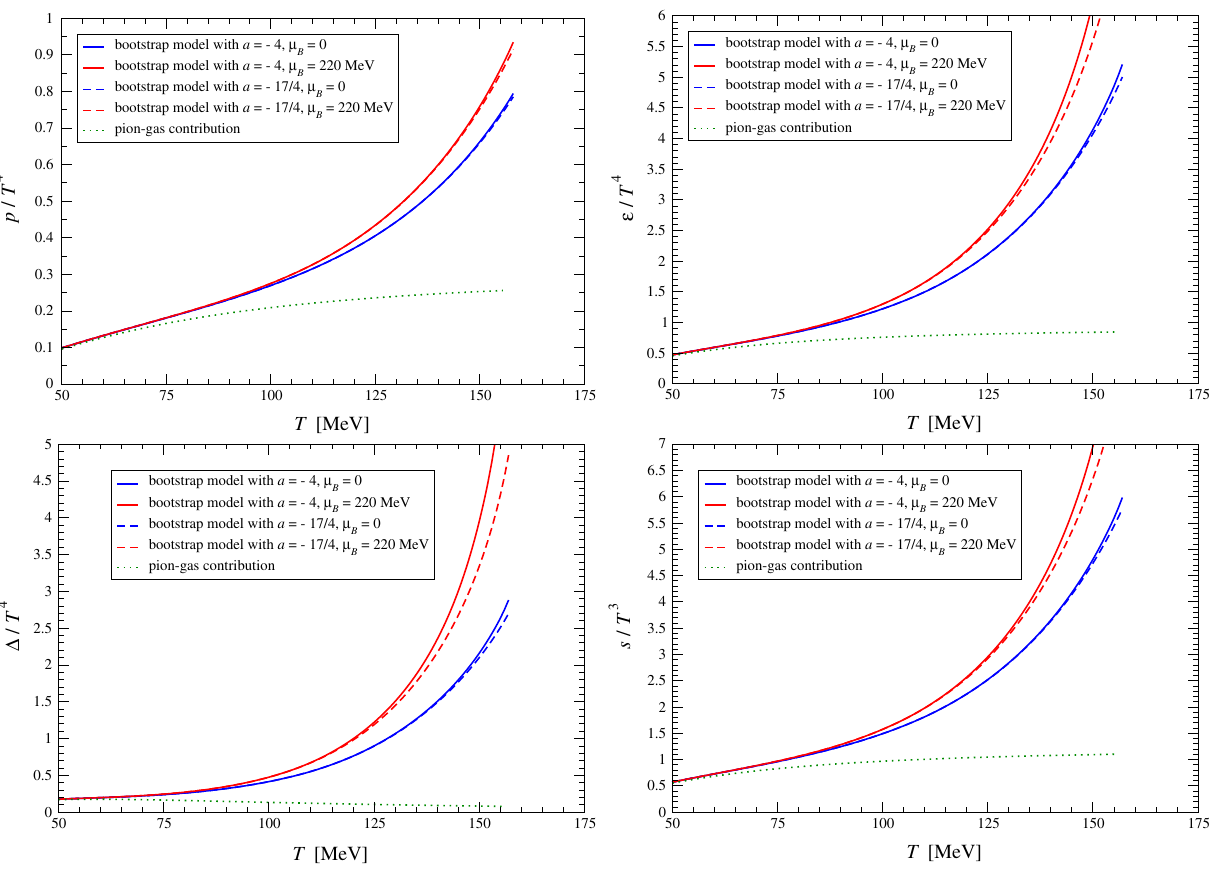
Fig. 1 Equilibrium thermodynamics quantities for different types of continuous resonance spectrum distributions, as a function of the tem- perature T , in MeV. The four panels show the pressure p (top left), the energy density ε (top right), and the trace of the energy-momentum tensor (cid:22) = ε − 3 p (bottom left) in units of T 4 , and the entropy den- sity s (bottom right) in units of T 3 . The solid curves correspond to ρ ( m ) = A a exp ( bm ) with a = − 4, whereas the dashed curves are 1 1 m obtained for a = − 17 / 4. The quark chemical potential is assumed to